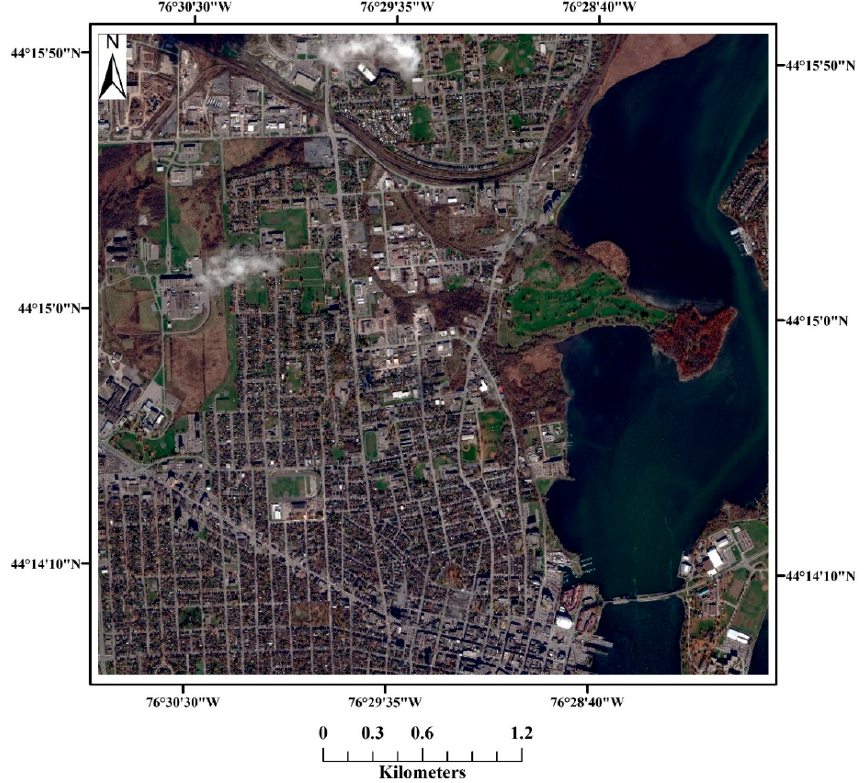
Figure 2. 50 cm WorldView-2 image covering a subregion the city of Kingston, Ontario, Canada.